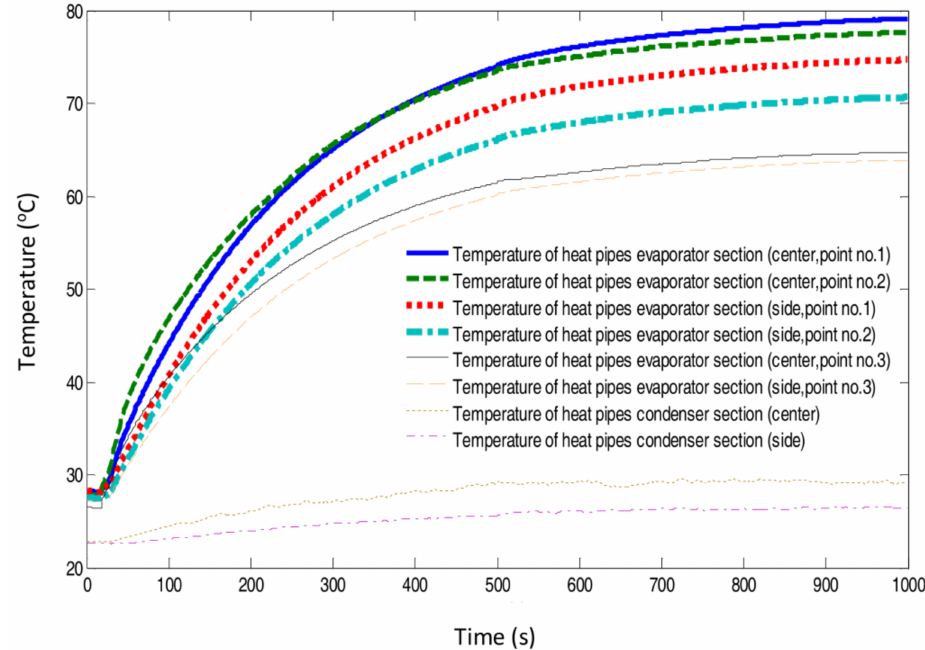
Figure 5. Temperature as a function of time in the evaporator and the condenser section of the heat pipes (diameter of 6 mm, effective length of 190 mm and pressed thickness of 2 mm and width of